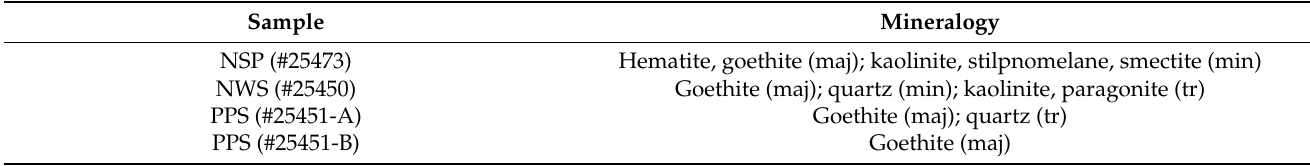
Table 2. XRD mineralogy of the >300 µ m fraction of cored material from ferruginous nodules and pisoliths from drill core material selected for (U-Th)/He-dating. maj=major; Tr=trace;